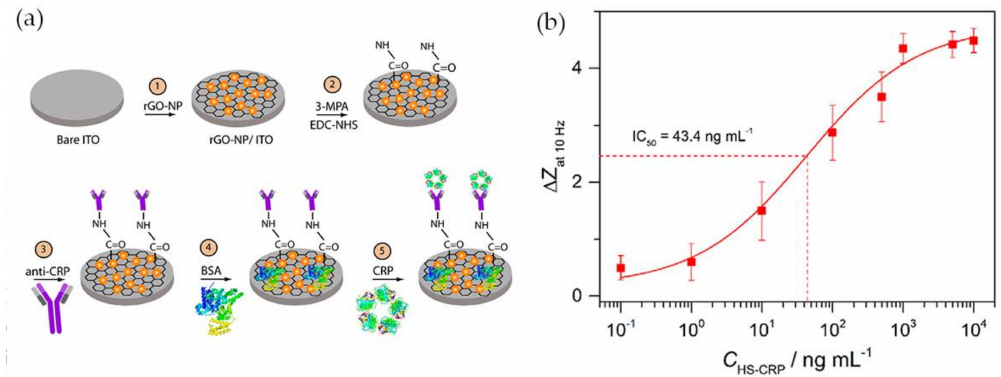
Figure 5. ( a ) Schematic illustration of anti-CRP/MPA/rGO-Au NP/ITO biosensor; ( b ) Calibration curve of CRP impedance biosensor in human serum spiked with CRP (HS-CRP). Reproduced with permission from ref. [57]. Copyright Elsevier, 2015.